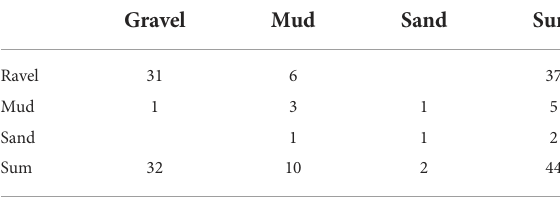
TABLE 5 Contingency table of the maximum likelihood classi fi cation.